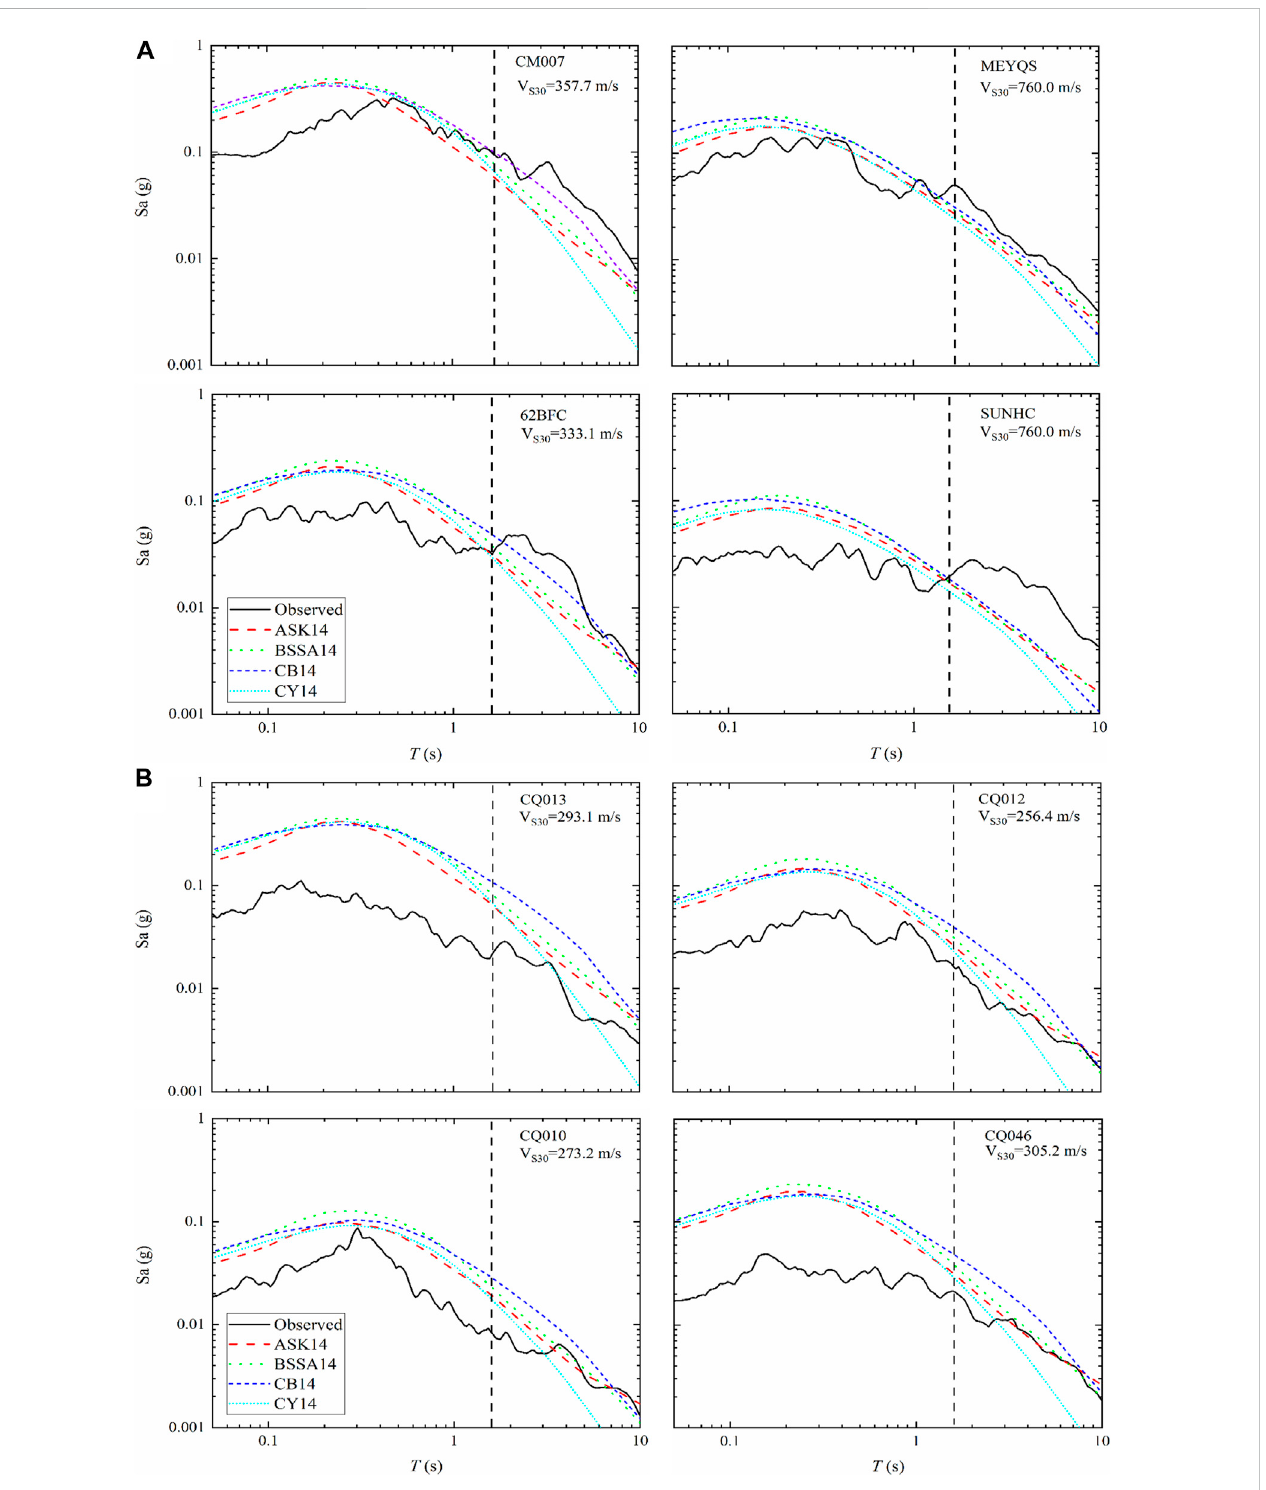
FIGURE 4 Observed horizontal spectral acceleration response in the rupture (A) forward and (B) backward directions and comparison with the predictions of the NGA-West2 models. ASK14, BSSA14, CB14, and CY14 denote the predictions of Abrahamson et al. (2014), Boore et al. (2014), Campbell and Bozorgnia (2014), and Chiou and Youngs (2014),